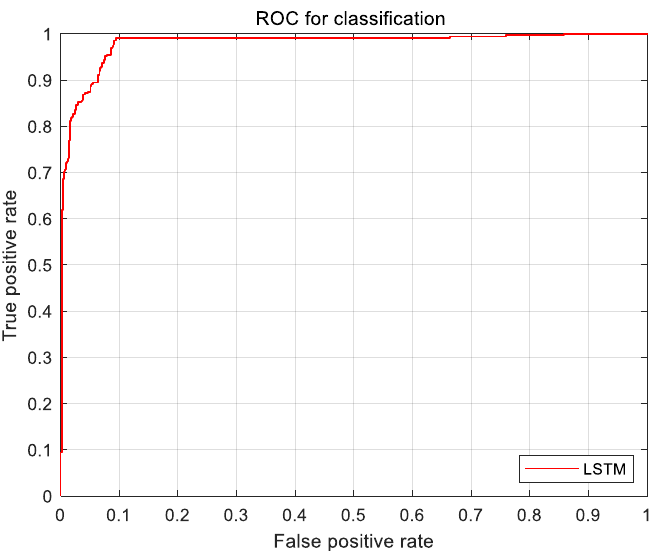
Figure 8. Receiver operating characteristic (ROC) curves for the case of no traffic in front of the vehicle.